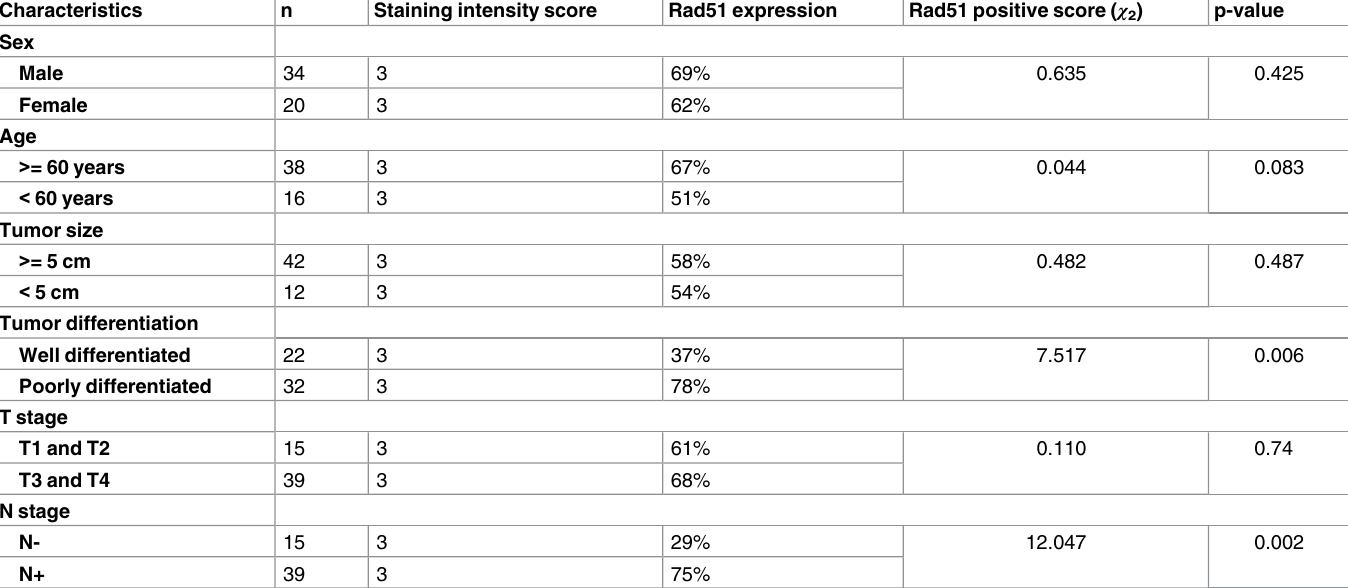
Table 2. Correlation of Rad51 expression with clinicopathological